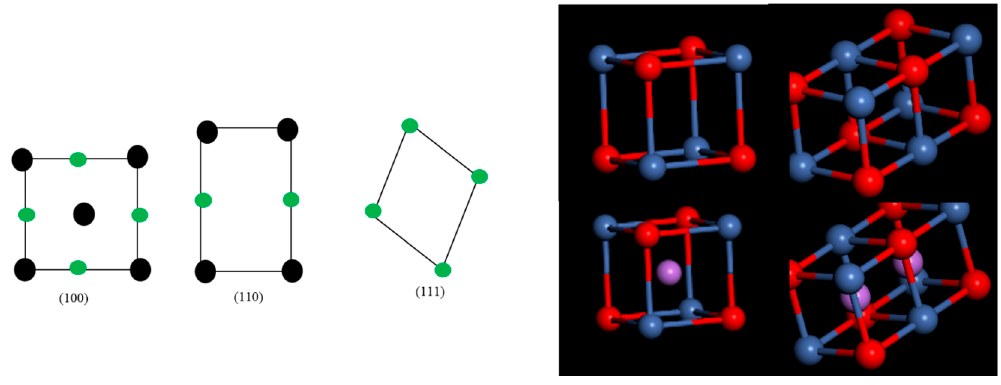
Figure 5. Constructed nanoparticles for NiO and Li-inserted NiO.